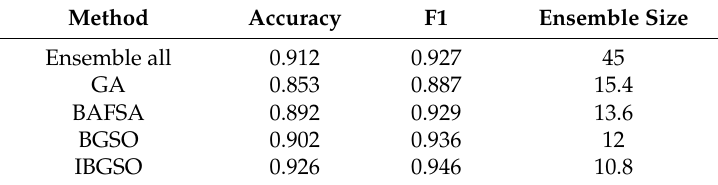
Table 8. Performance comparison for the five approaches using the OPPORTUNITY dataset.